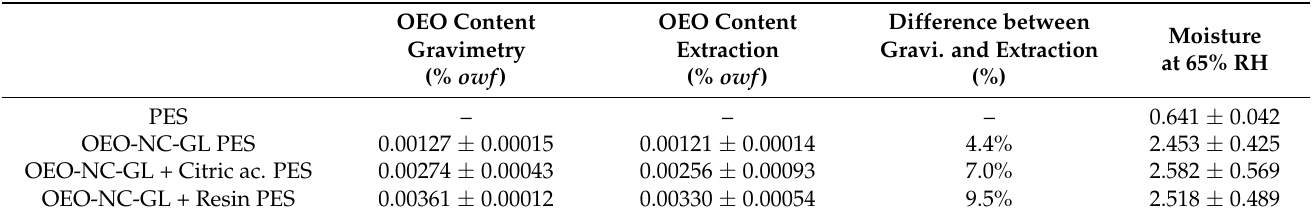
Table 2. OEO content obtained from the gravimetrical and extraction methods and moisture content of the PES